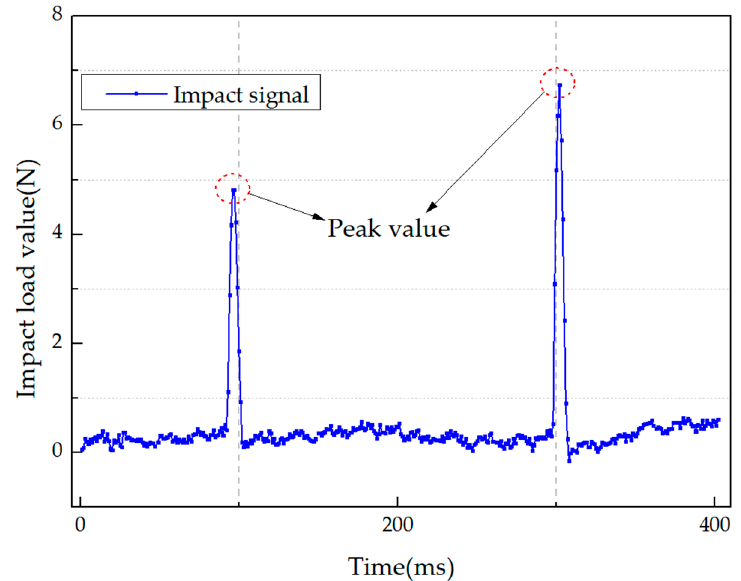
Figure 10. The peak value of impact signal of two successive impacts.